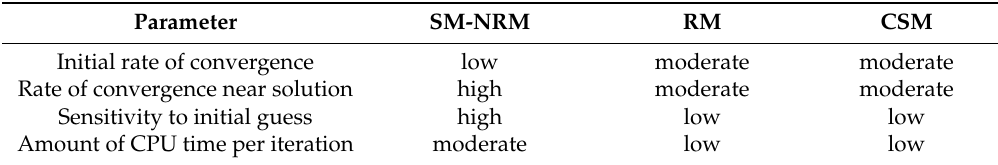
Figure 12. Dependence of the residual, CPU time and absolute error on iteration number for: CSM, RM and SM-NRM. The pump power equals 5 W. Figure adapted from [33]. Table 1. A summary of main characteristics of SM-NRM, RM and